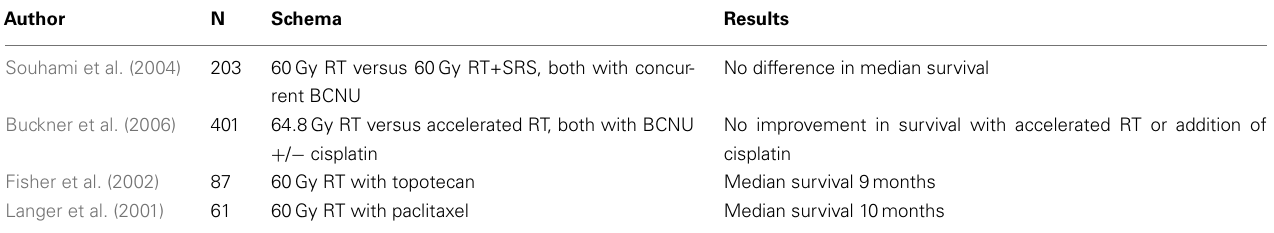
Table 2 | Pre-temozolomide trials.